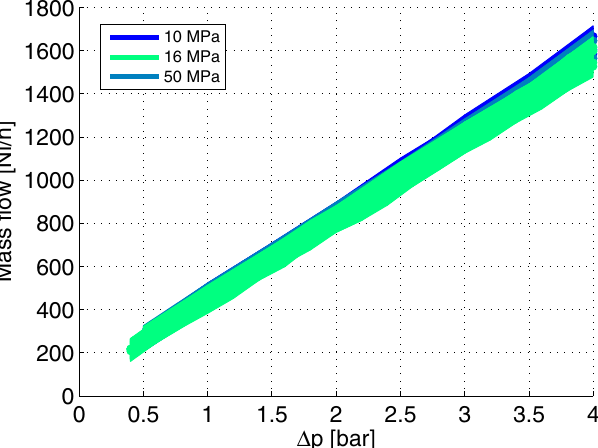
FIG. 14. (Color) Radial flow in cables with enhanced insulation. Vertical compression of 10, 16, and 50